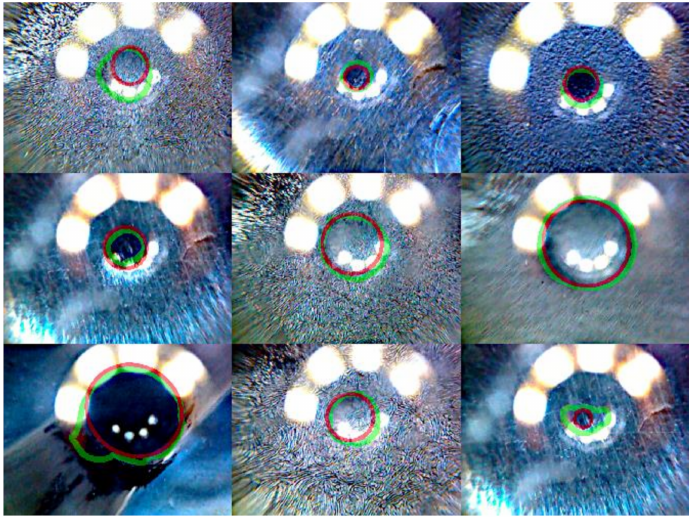
Figure 8. Contact area change over frames for all models trained in this work, color coded by video. Frames 0 to ~2400 show stage 1 (i.e., the spherical counterpart being slowly lowered into the rubber sample). Frame~2400 to ~6000 show stage 2 (i.e., the rotary table being spun to create friction). This is followed by stage 3 (i.e., the spherical counterpart being removed from the sample). The curves for each video were strongly aligned (i.e., model choice has little impact on the resulting contact area curves). Visible di ff erences only occurred at the very beginning as well as at the transition between stages 1 and 2.